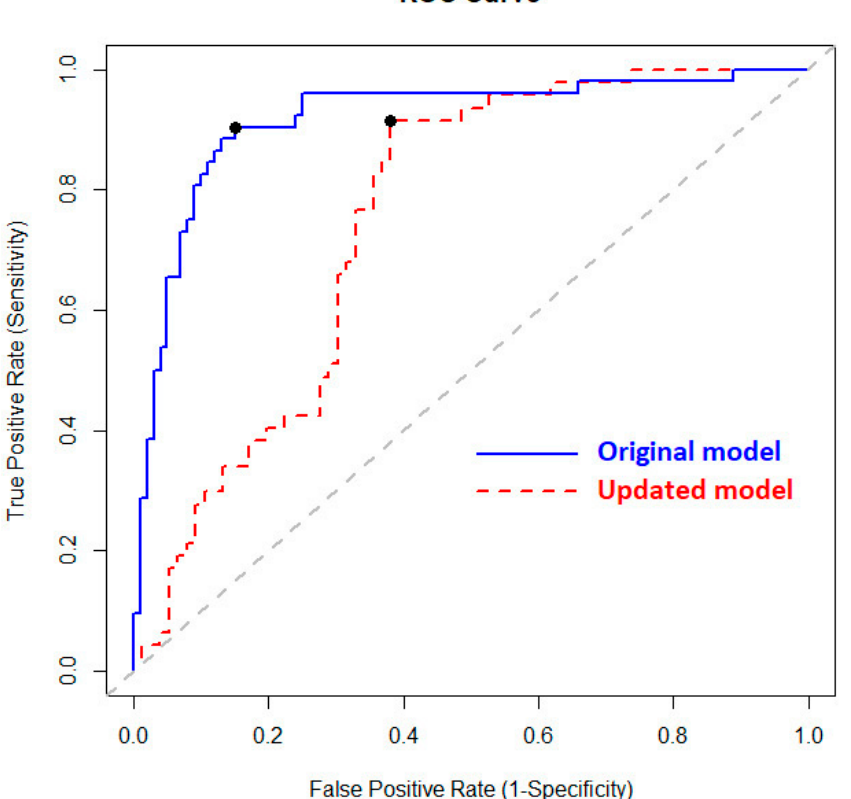
Figure 1. Receiver operating characteristics (ROC) curve of the original (discovery study) and updated (validation study) prediction models, reflecting the models’ predictive ability as estimated by leave-one-out cross-validation. The area under the curve (AUC) is 92% (95% CI: 86–96%) for the original model and 75% (95% CI: 66–83%) for the updated model. The marked points (black dots) correspond to the determined decision thresholds of both models (cut-off value original model: 0.369, cut-off value updated model: 0.358).